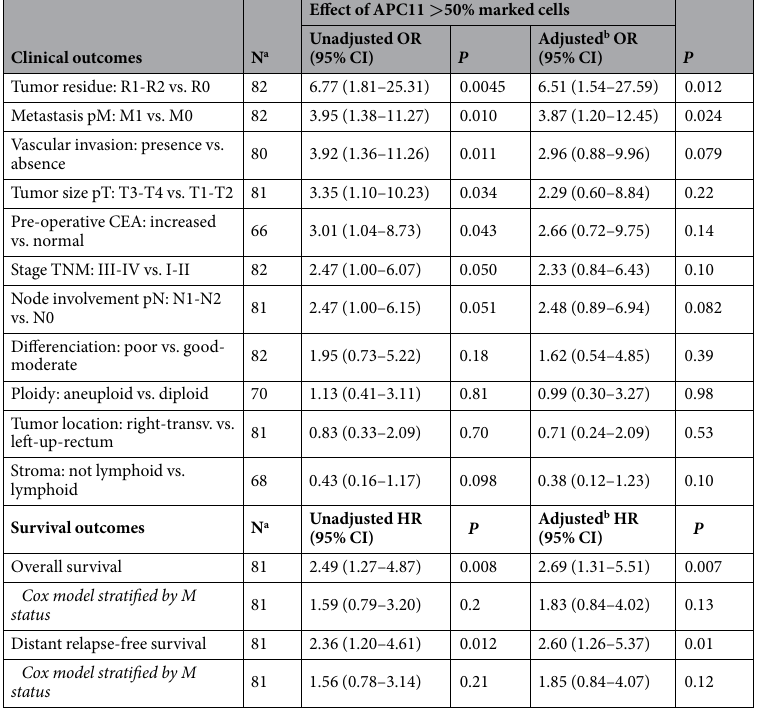
Table 3. Association of APC11 > 50% with clinical and survival outcomes. a Number of patients with available data. b Adjusted ORs and HRs were obtained from multivariable logistic and Cox regression models